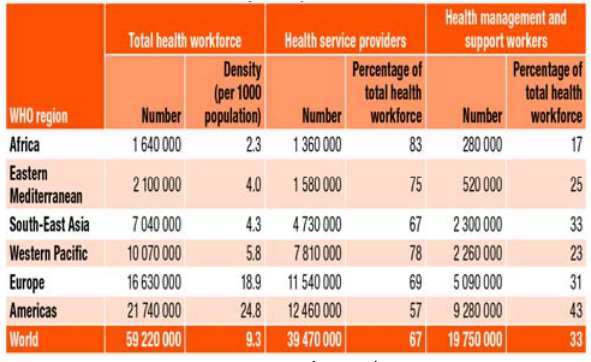
Source: World Health Report (WHR) 2006